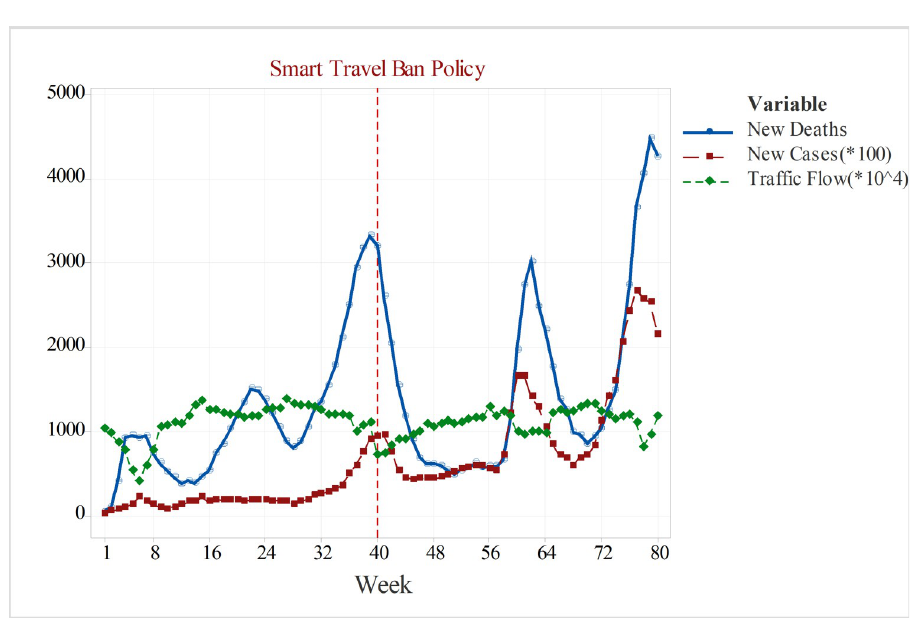
Fig 1. Weekly new COVID deaths and cases ( � 10 2 ) and weekly intercity traffic flow ( � 10 4 ) in Iran.